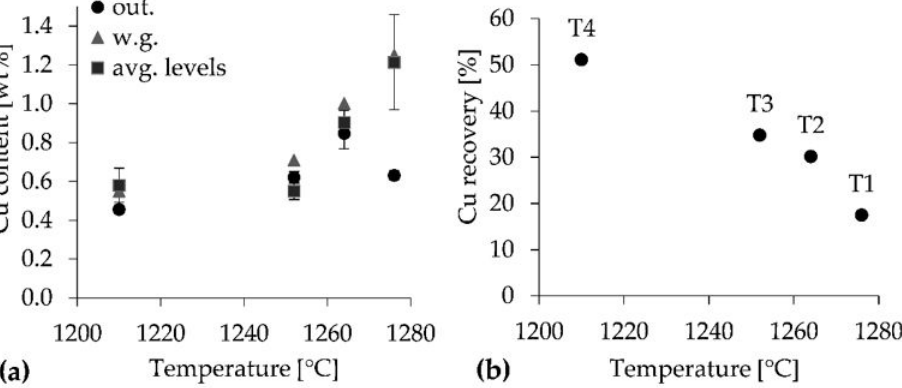
Figure 2. ( a ) Effect of the temperature on the copper content of average outgoing (out.), vertical slag (avg. levels), and water-granulated slag (w.g.) samples when the settling time was ~30 min; ( b ) copper recovery in the settling furnace versus the